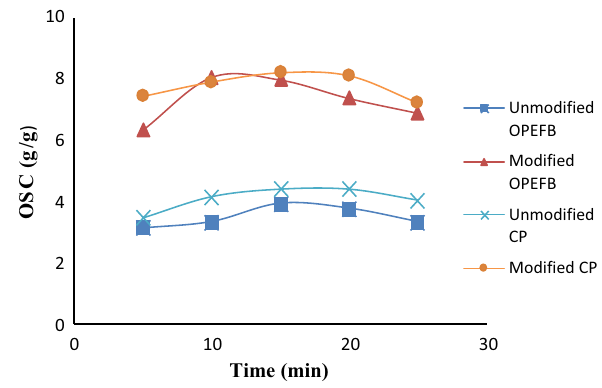
Fig. 6 Effect of contact time on crude oil sorption capacity (OSC) of the